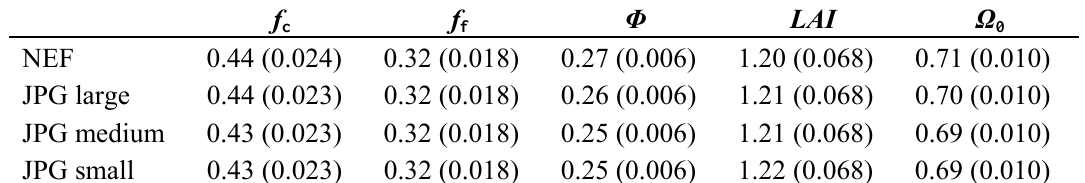
), foliage cover ( f ) and c f